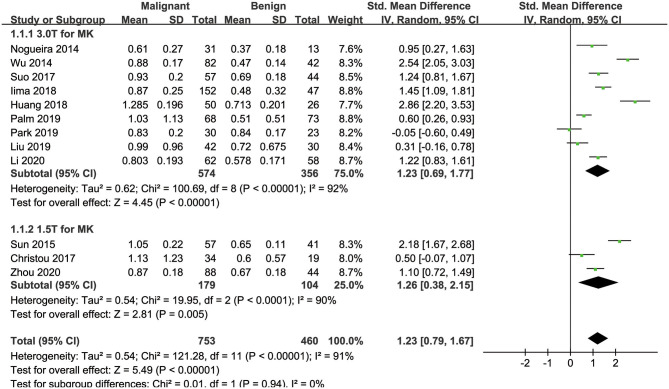
Forest plot of the mean value of the mean kurtosis (MK) between malignant and benign breast lesions. The standardized mean differences indicated that breast cancers had a significantly higher MK than benign lesions.